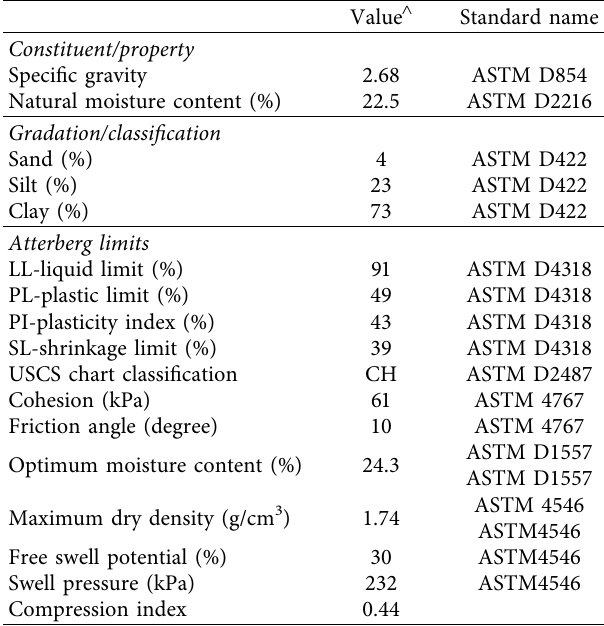
Table 4: Summary of geotechnical engineering characteristics of expansive clay